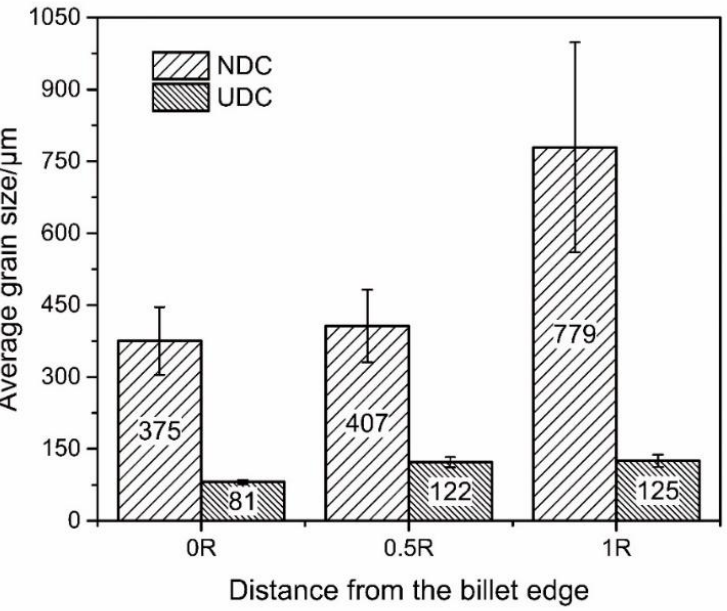
Zn–Mg–Cu alloy billets prepared by NDC casting ( a , b and c ) and UDC casing ( d , e and f ).